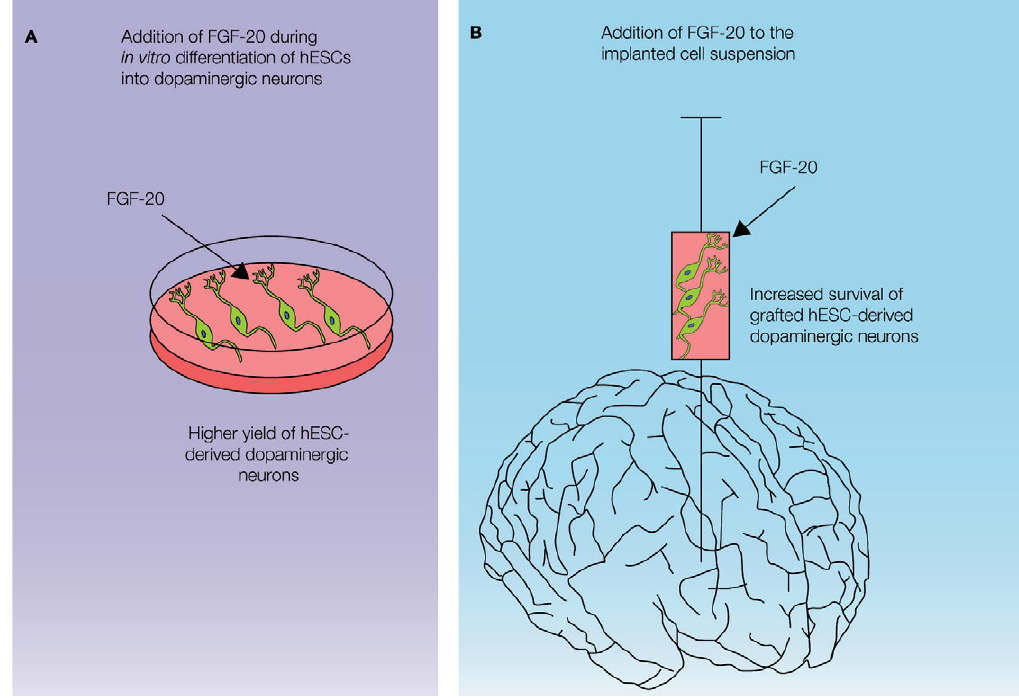
Figure 3 | Possible applications of FGF-20 in a cell-based therapy for Parkinson’s